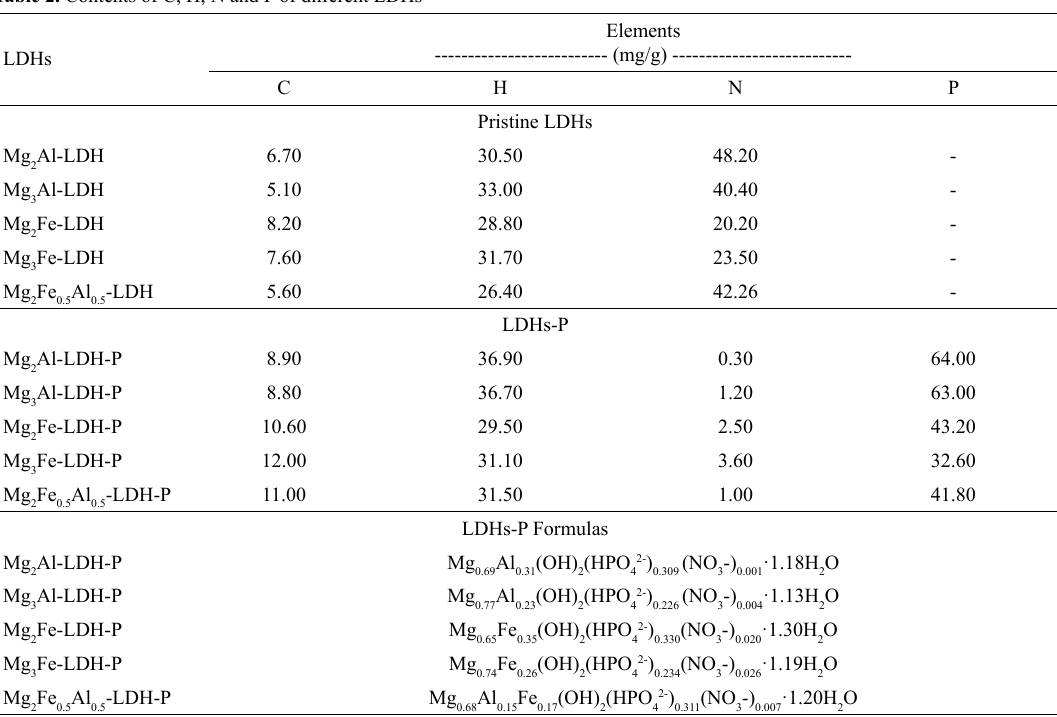
Table 2. Contents of C, H, N and P of different LDHs